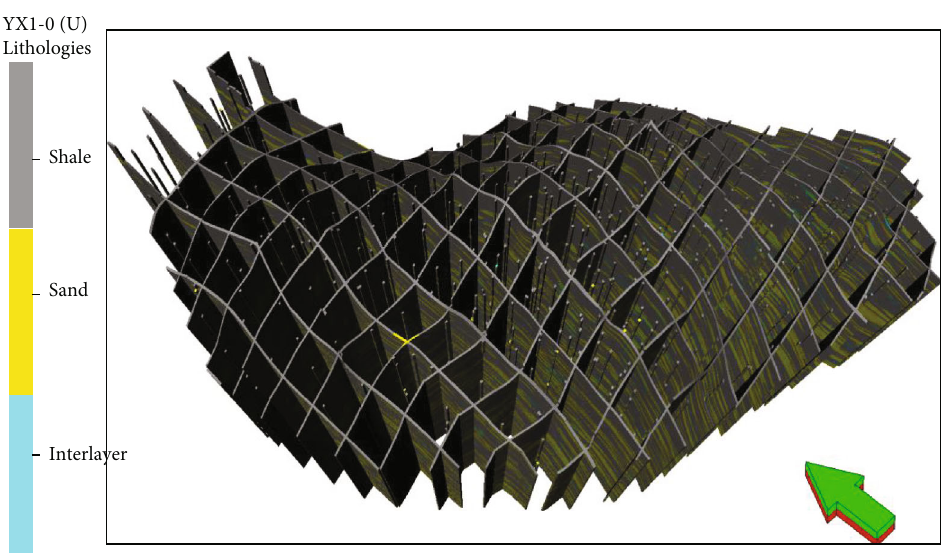
Figure 13: 3D lithofacies model of the study